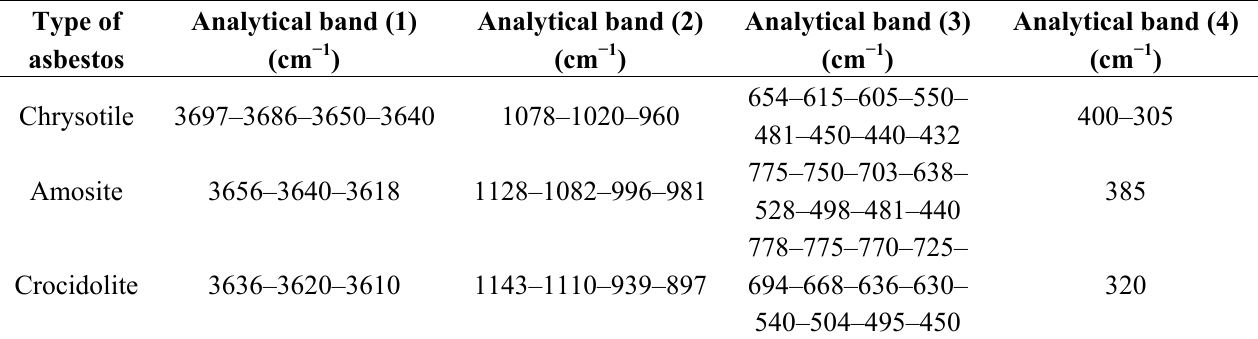
Table 1. Absorption peaks for different types of